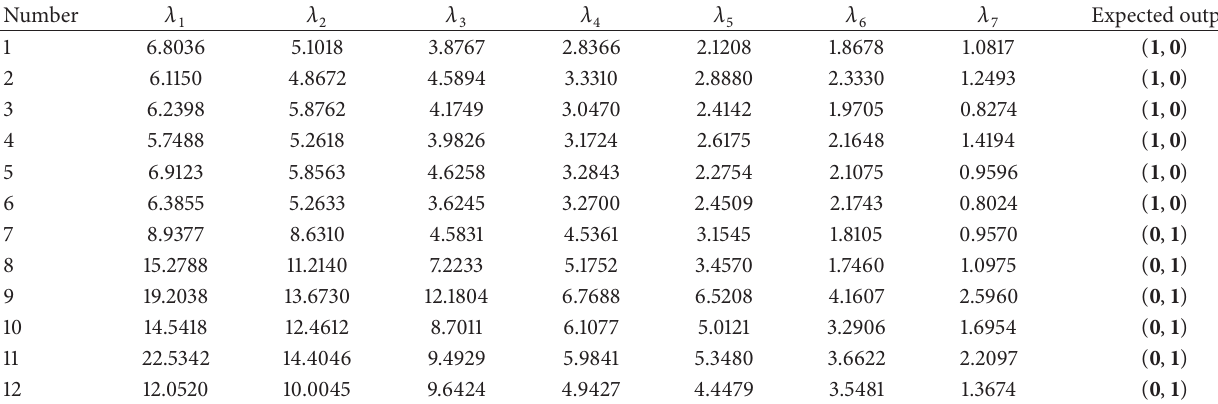
Table 2: Samples for singular values of IMFs.